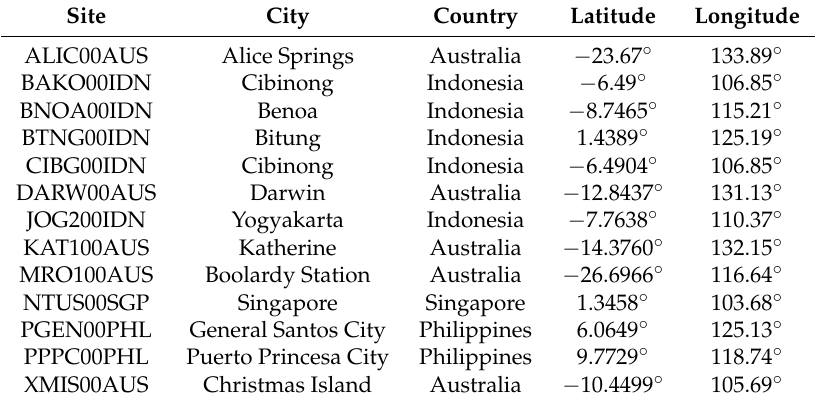
Table 1. Geographic location of the International GNSS Service stations used for the vTEC